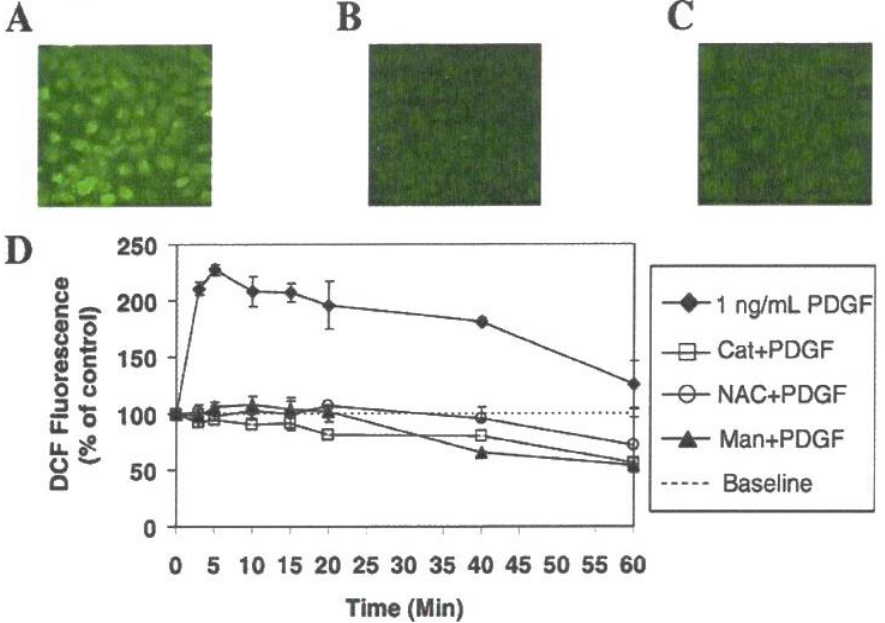
Figure 8. Confocal images of intracellular ROS generation upon platelet-derived growth factor (PDGF) stimulation in live HLE cells. Live HLE cells were preloaded with DCFH-DA (50 µ M) to capture the ROS generated upon PDGF (1 ng/mL) stimulation. Confocal cell images represent a random field after PDGF exposure. ( A ) PDGF-stimulated cells at 10 min. ( B ) Non-PDGF-stimulated cells at 10 min. ( C ) Catalase (I mg/mL) preloaded cells at 10 min after PDGF exposure. ( D ) Inhibition of PDGF-stimulated ROS generation by antioxidants and free radical scavengers. Inhibition of the DCF fluorescence induced by PDGF (1 ng/mL) in situ is expressed as a function of time in the presence of catalase (1 mg/mL), N-acetylcysteine (NAC, 30 mM) or mannitol (Man, 100 µ M). The data are expressed as the mean ± SD with n = 3. (cid:7) , cells stimulated by 1 ng/mL PDGF alone with ◦ no preloading; , cells preloaded with N-acetylcysteine (NAC, 30 mM);